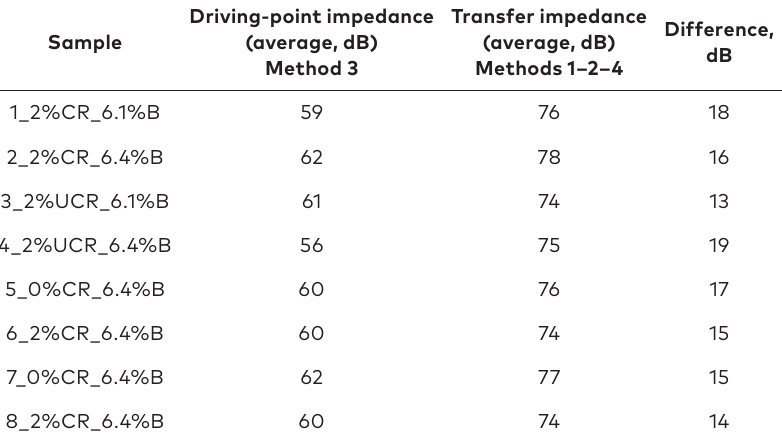
Table 10. Difference (in dB, re 1 N·s/m) between driving-point and transfer impedance (frequency-based